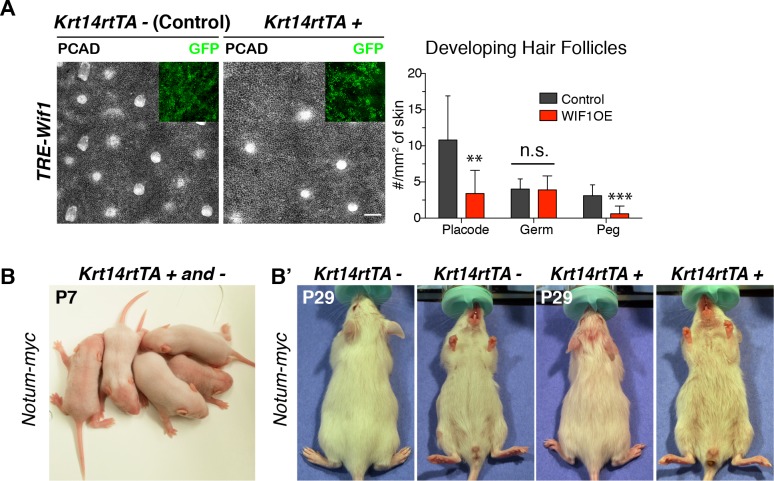
WNT inhibitor overexpression perturbs hair follicle formation.(A) Whole mount immunofluorescence and quantifications reveals that elevating WIF1 across the epidermal plane results in significantly fewer developing hair follicles beginning at the placode stage. Insets verify that the skin regions shown were transduced (GFP+) (Mean ± SD; n > 18 mm2 skin analyzed; **p<0.05; ***p<0.005; n.s. non-significant; unpaired Student t test). Scale Bar, 100 μm. OE, overexpression. (B–B’) Sparser hair coat upon ectopic Notum expression. Example of neonatal litter, some of which overexpress NOTUM and show a sparser hair coat than their control littermates. Note also the sparser hair coat of a representative P29 adult mouse that is positive for Notum overexpression, when compared to its uninduced control littermate.Figure 6—figure supplement 1—source data 1.Source data for the graphs shown in Figure 6—figure supplement 1A.